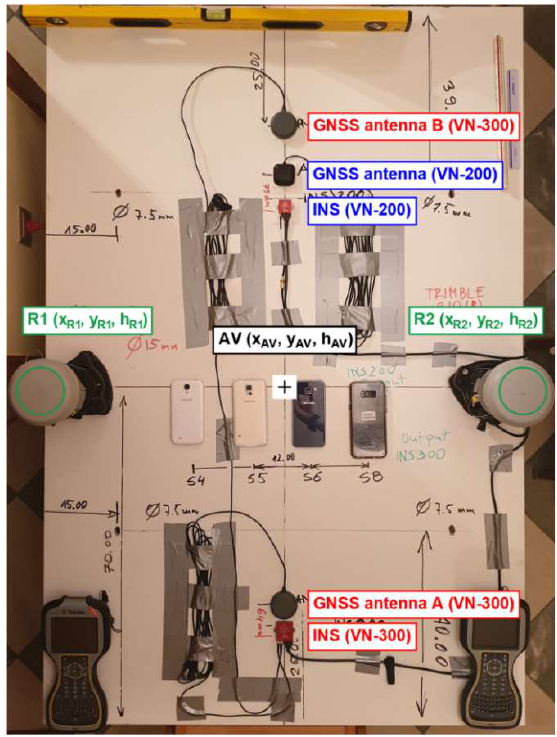
Figure 5. Geometric relationships between the tested devices mounted on the measurement platform.